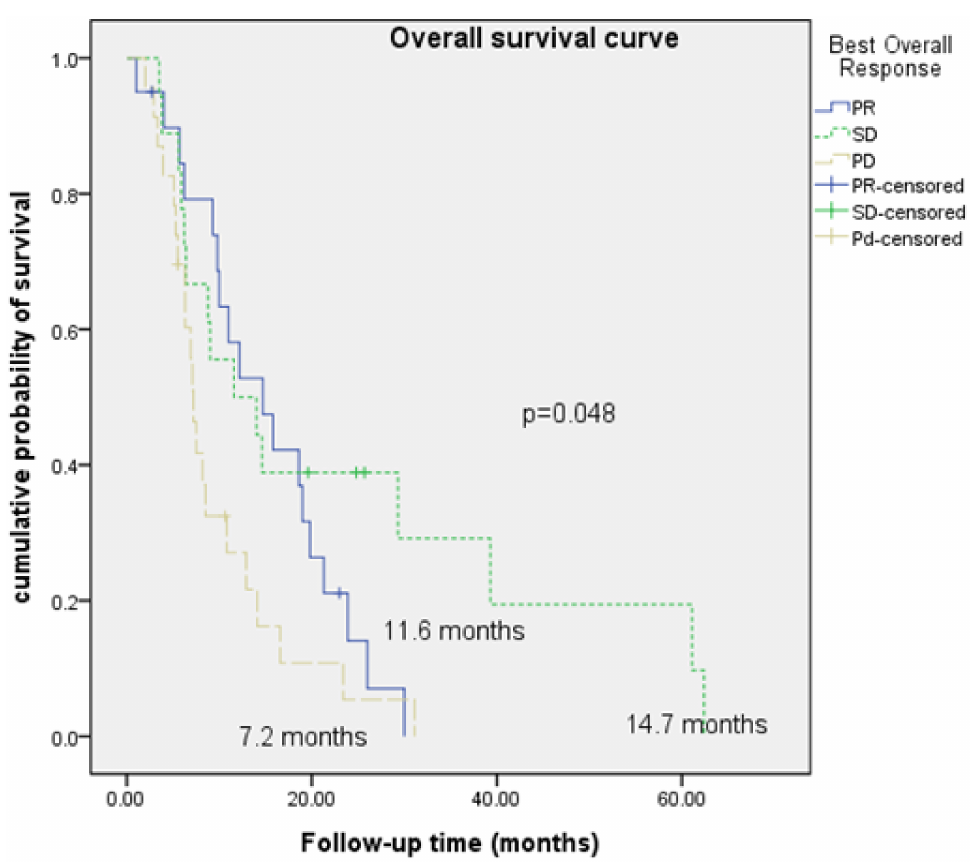
Fig 2. Overall survival curves among best overall response groups treated with first-line